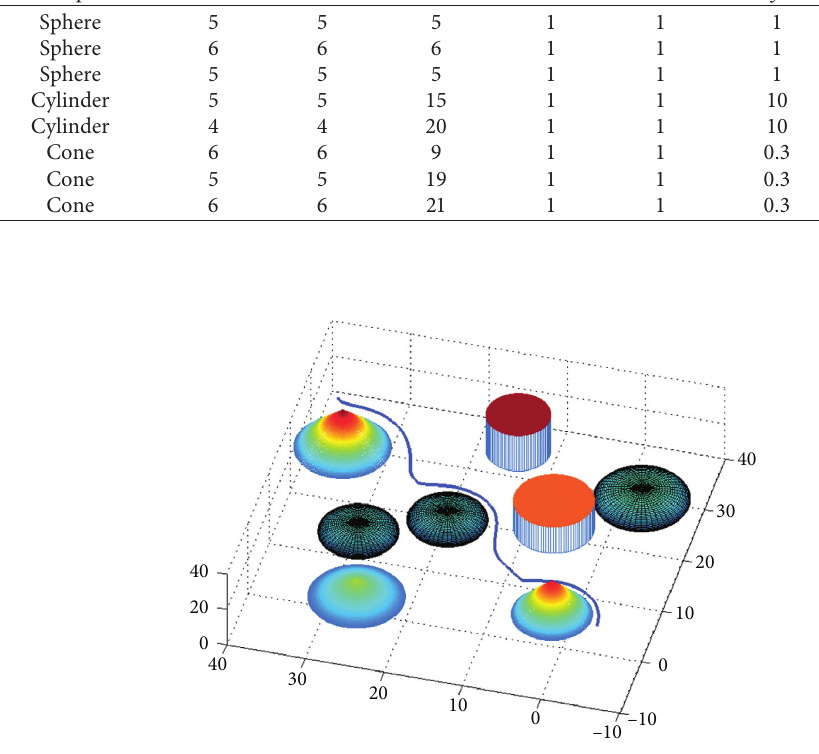
Figure 3: Goal-directed locomotion that the robot does not need to climb obstacles from different starting positions.